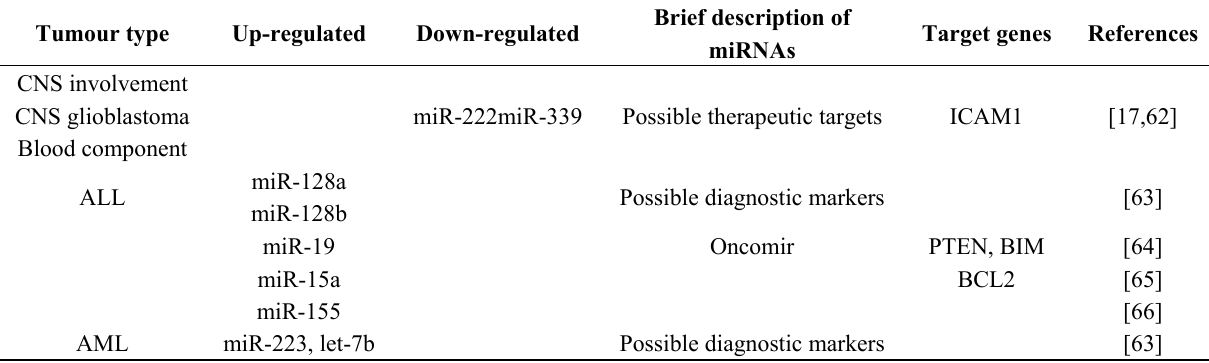
Table 3. Tumour types with miRNA expression against gene